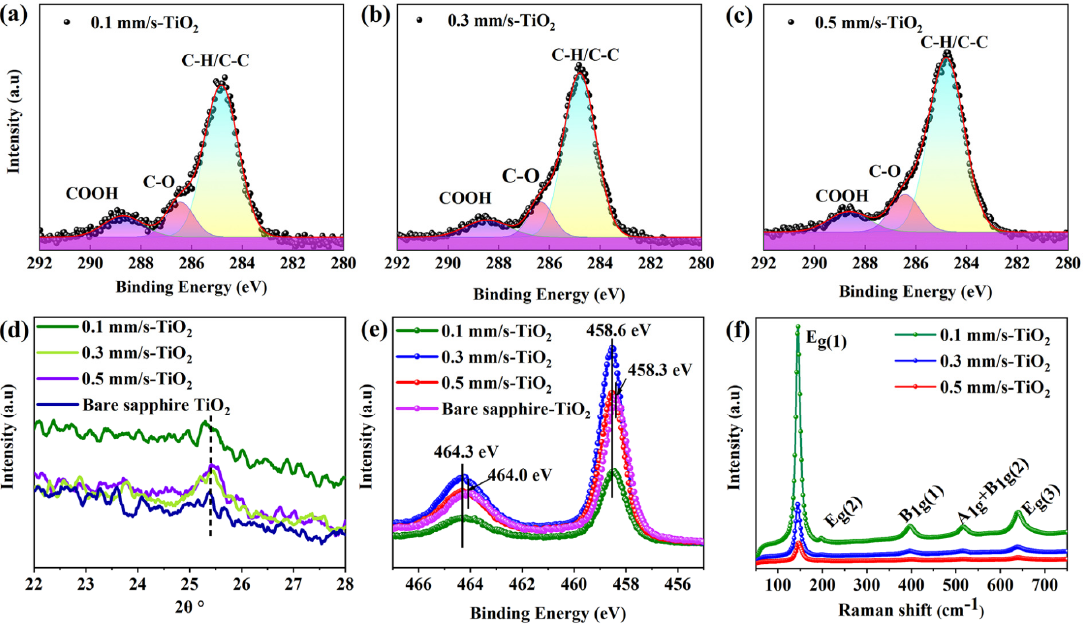
Figure 4. Characterization of the chemical change on Laser-TiO 2 surfaces. ( a – c ) Measured XPS results of C 1 s spectra for the Laser-TiO 2 surfaces with different scanning speeds; ( d – f ) Measured XRD, XPS (Ti 2 p), Raman spectra for the Laser-TiO 2 surfaces with different scanning speeds.